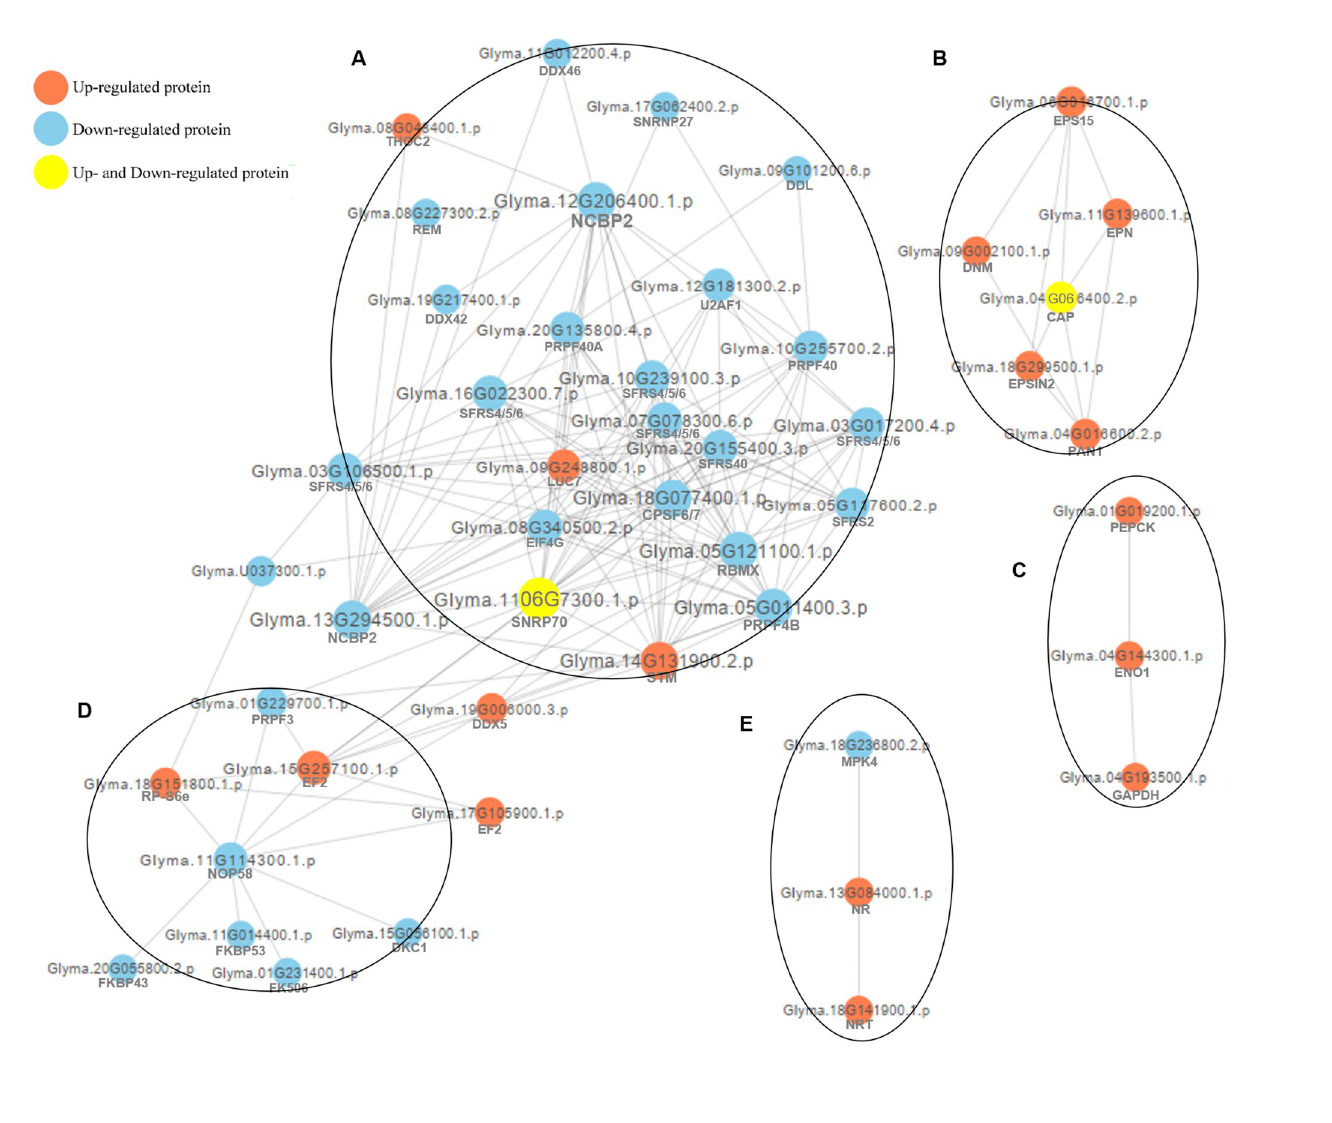
Fig 3. Protein-protein interaction networks of differentially phosphorylated proteins (DPPs) under Al 3+ treatment in TBS seedlings. (A) Spliceosome; (B) Membrane trafficking; (C) Carbohydrate metabolism; (D) Ribosome biogenesis in eukaryotes; (E) Signal transduction. https://doi.org/10.1371/journal.pone.0237845.g003 For translation, eukaryotic translation initiation factors (EIF) (Glyma.03G106500.1.p, Gly- ma.08G340500.2.p and Glyma.U037300.1.p) were hypophosphorylated by Al 3+ , while EIF 4B2 was upregulated and downregulated at Ser and Ser , respectively. Peptidyl-prolyl cis-trans 510 501 isomerases, which allow proteins to fold into their correct conformations, were hypopho- sphorylated by Al 3+ , including CYP63 (Glyma.03G157900.2.p) and FKBPs (Glyma.01G231 400.1.p, Glyma.11G014400.1.p and Glyma.20G055800.2.p). In addition, Al 3+ upregulated the phosphorylation of the ribosomal proteins S6 and S11. Regarding post-translational modifica- tions, 4 E3 ubiquitin-protein ligases were found, with ATL6 (Glyma.10G156500.1.p), LIN1 (Glyma.10G194500.2.p) and MARCH7 (Glyma.13G139200.3.p) upregulated, and RBBP6 (Glyma.17G143300.2.p) downregulated.